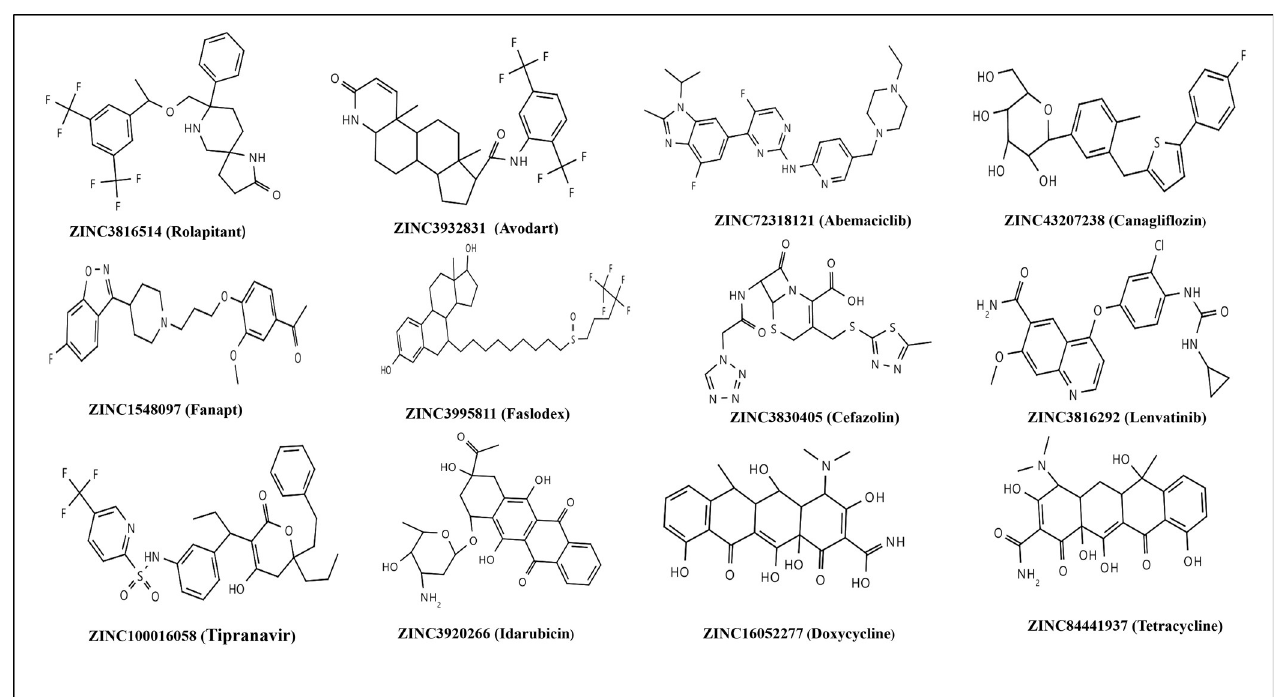
Fig 5. Twelve top-ranked FDA approaved Library from ZINC